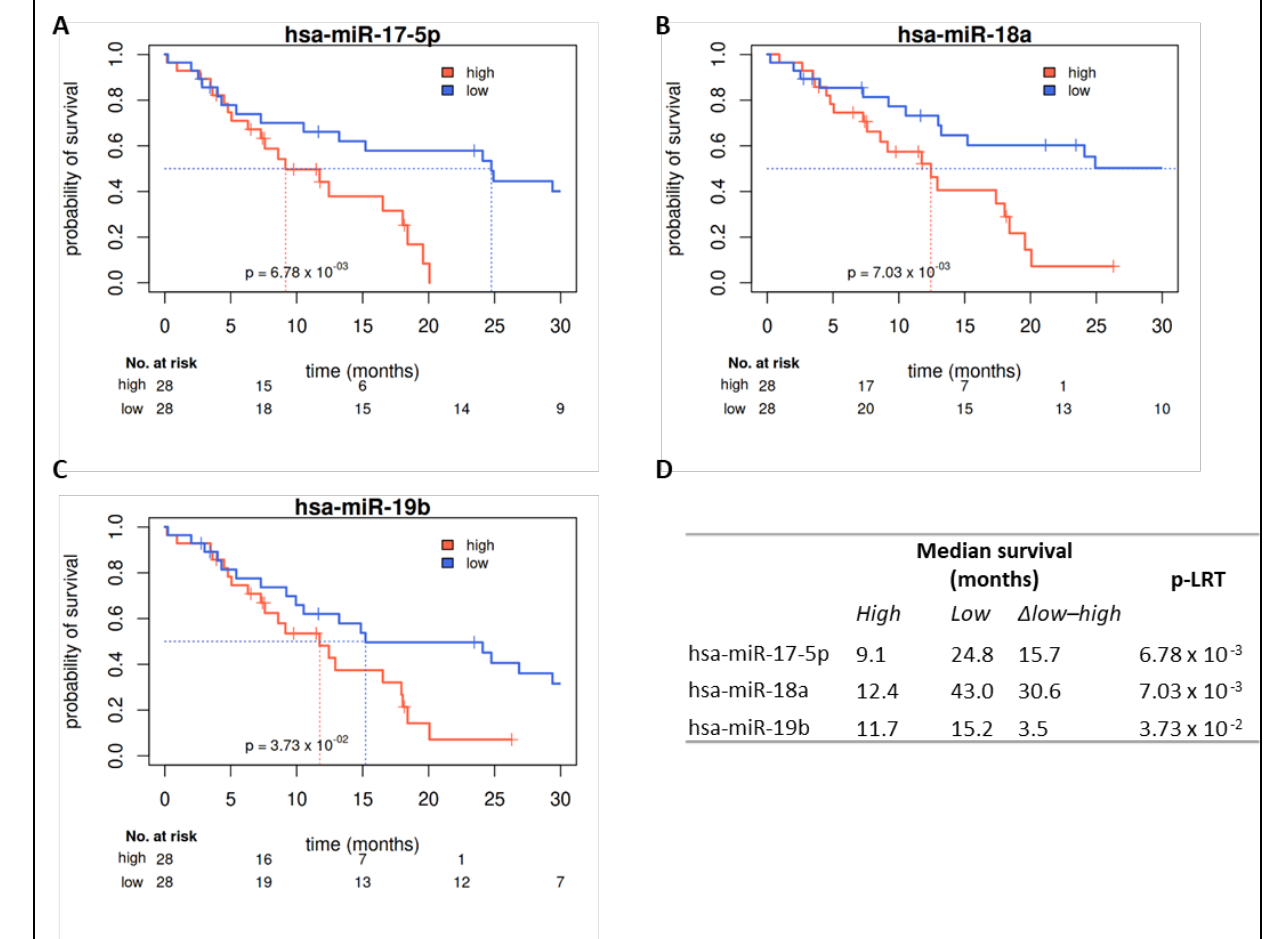
Figure 4. Prognostic impact of members of miR-17-92 in the HD cohort. Kaplan–Meier survival curves for overall survival. High expression of miR-17-5p, miR-18a, and miR-19b is associated with shorter overall survival ( A – C ), with median survival differences of 3.5 to 30.6 months. Median survival differences and p -values are shown in ( D ) (Kaplan–Meier estimators and likelihood ratio tests for groups of patients with expression below the first vs. above the third quartile).